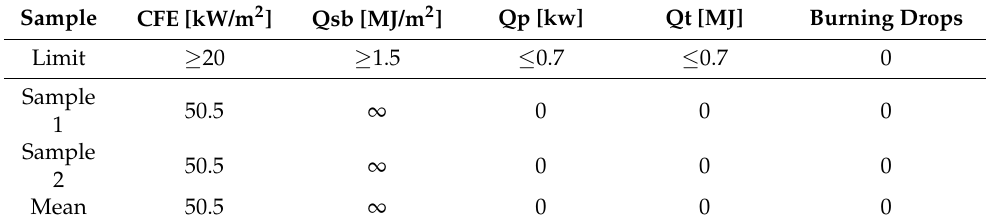
Table 4. Resulting parameters of surface flammability test.